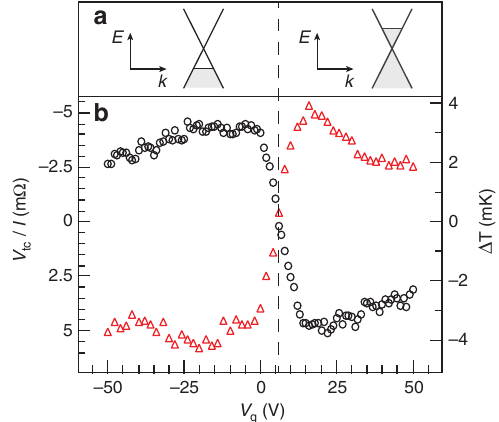
Figure 3 | Peltier effect in a forward and reverse biased graphene–Au interface. ( a ) Schematic of the linear dispersion for p-doped (left) and n-doped (right) SL graphene. ( b ) Measurement of the thermocouple signal V tc / I as a function of backgate voltage, for I ¼ 20 m A, with the configuration shown in Fig. 1a (black circles). V tc is converted into a temperature by using the Seebeck coefficient of the thermocouple S tc , as shown in the right axis. The hole regime shows heating, whereas the electron regime shows cooling. The vertical dashed line indicates the position of the Dirac point. For a reversed configuration of the current source (red triangles) the effects of cooling and heating are reversed.